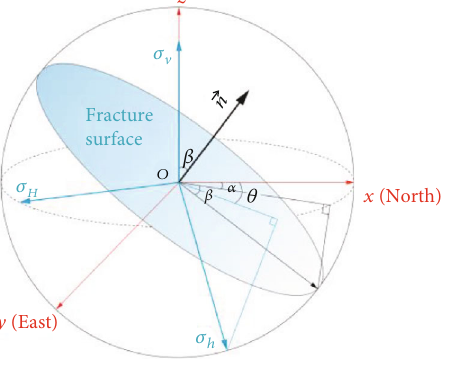
Figure 10: Schematic diagram of the orientation of discontinuity orientation in principle stress space.